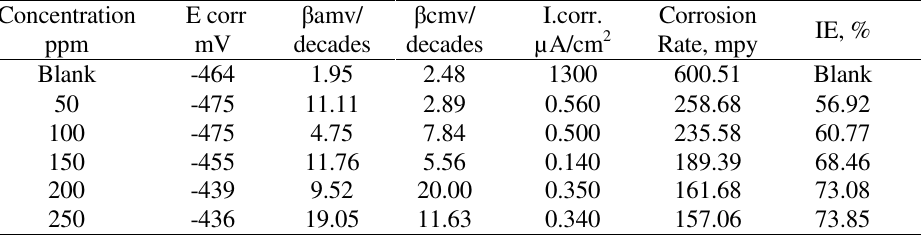
Table 2. Electrochemical parameters of mild steel corrosion in 1 M HCl solution contain various concentrations of Sodium Lauryl Sulfate (SLS) at 35 0 C.